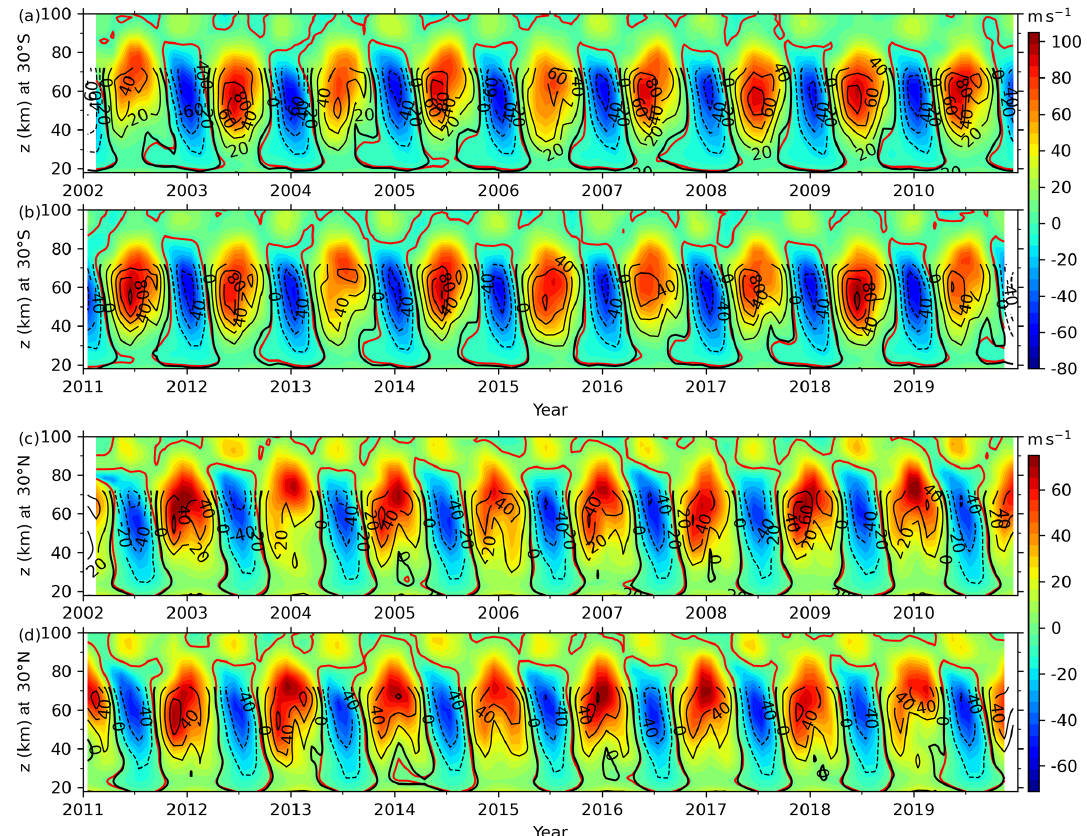
Figure 3. Time–height sections of the BU (color-filled contour, positive for eastward) and MerU (lines with contour interval of 20ms − 1 , the eastward and westward winds are represented as solid and dashed lines, respectively) at 30 ◦ S (a, b) and 30 ◦ N (c, d) . The red and thick black contour lines are the zero winds of BU of MerU, respectively. Different color scales are used at 30 ◦ S and 30 ◦ N. The ticks on the x axis mark the beginning of each